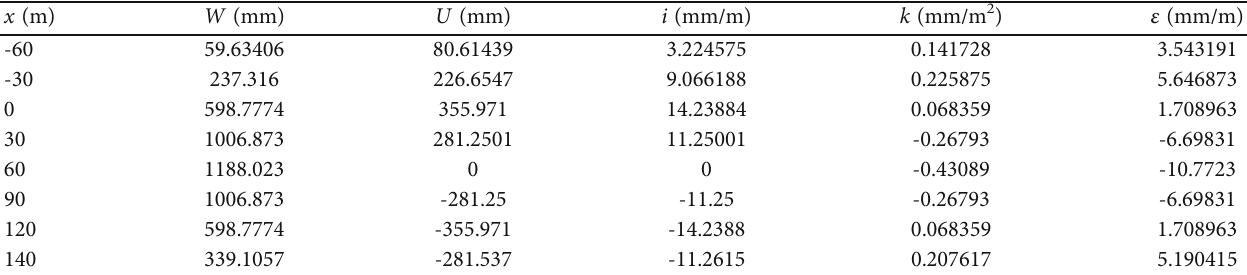
Table 2: Calculation results of case